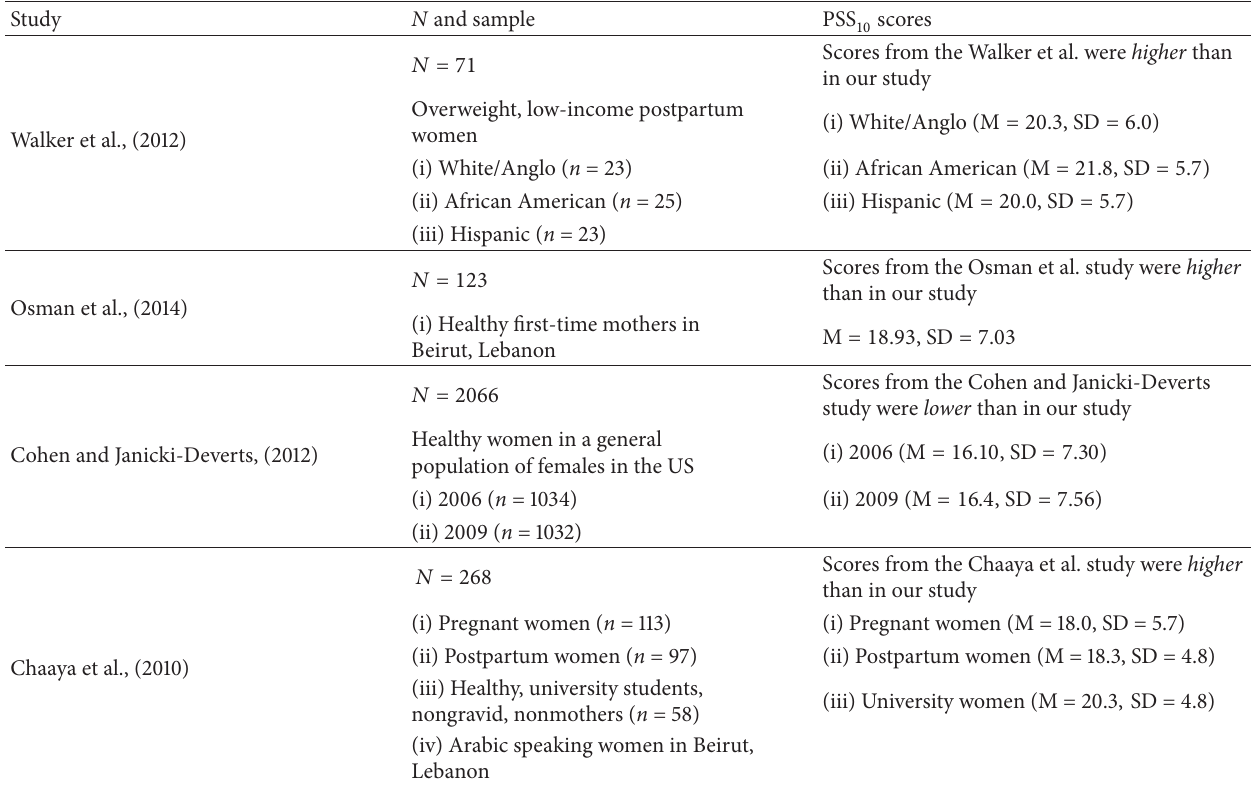
Table 4: Comparison of PSS 10 mean scores of new mothers in this study (M = 17.39 , SD = 5.9 ) to PSS 10 mean scores reported in the